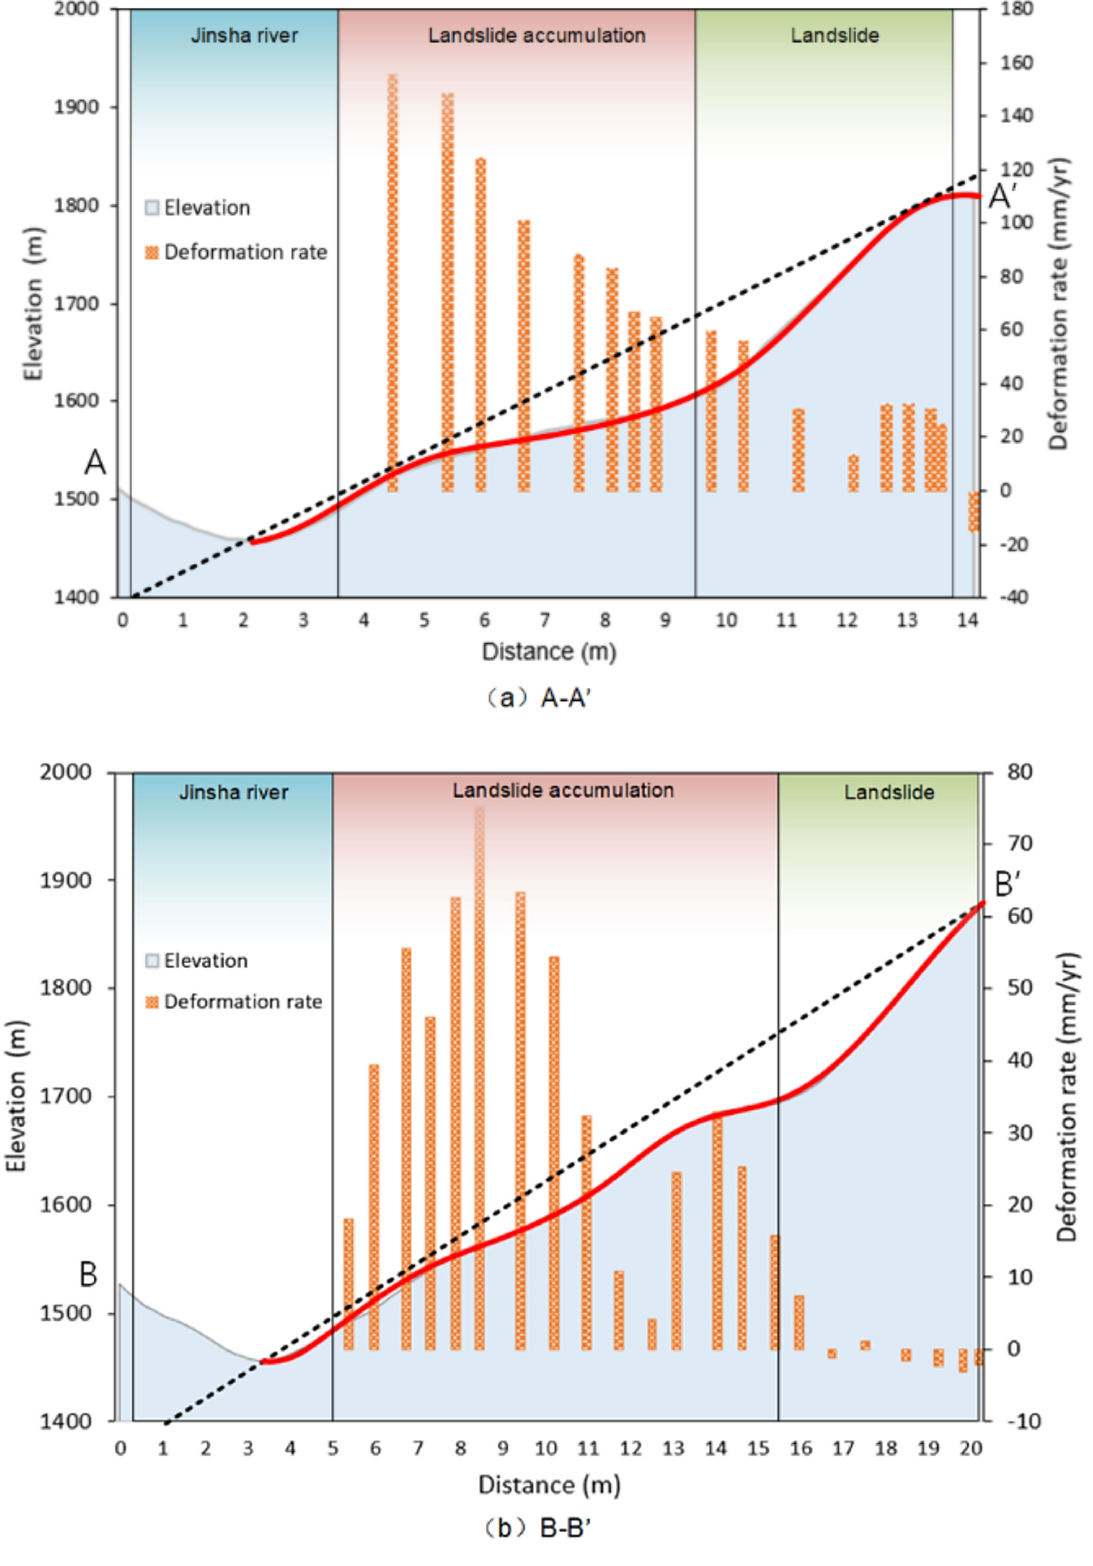
Figure 12. Deformation rates on section lines A-A’ and B-B’: ( a ) A-A’ and ( b ) B-B’.